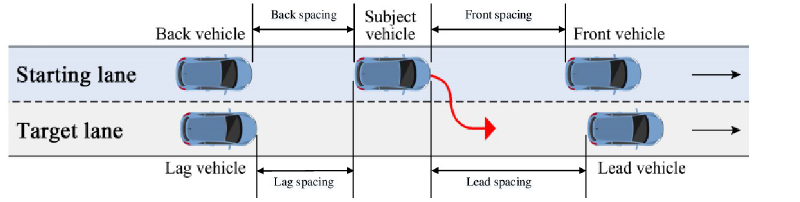
Fig 7. Definition of the parameters between the subject vehicle and other vehicles.